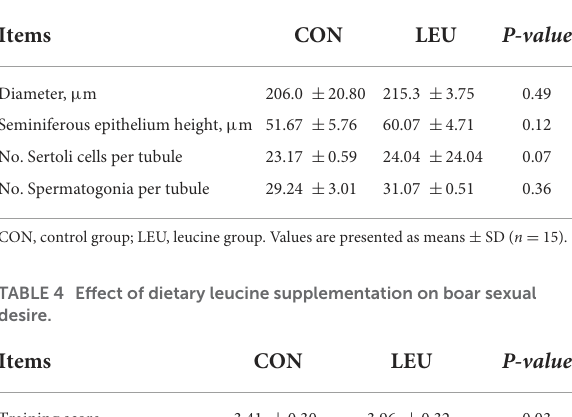
TABLE 3 Effects of dietary leucine supplementation on the histological structure of testis in 150-days-old boars.